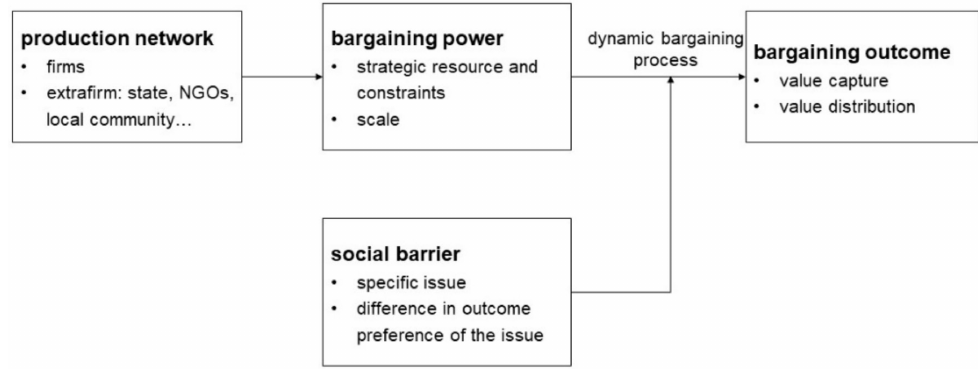
Figure 1. Incorporating social barriers into the global production network